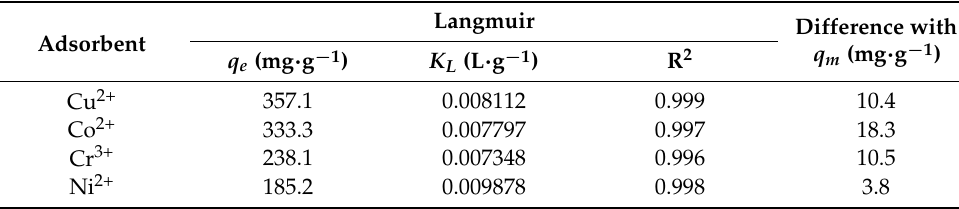
Table 3. Langmuir adsorption isotherm (linear) parameters of poly(hydroxamic acid) ligand.